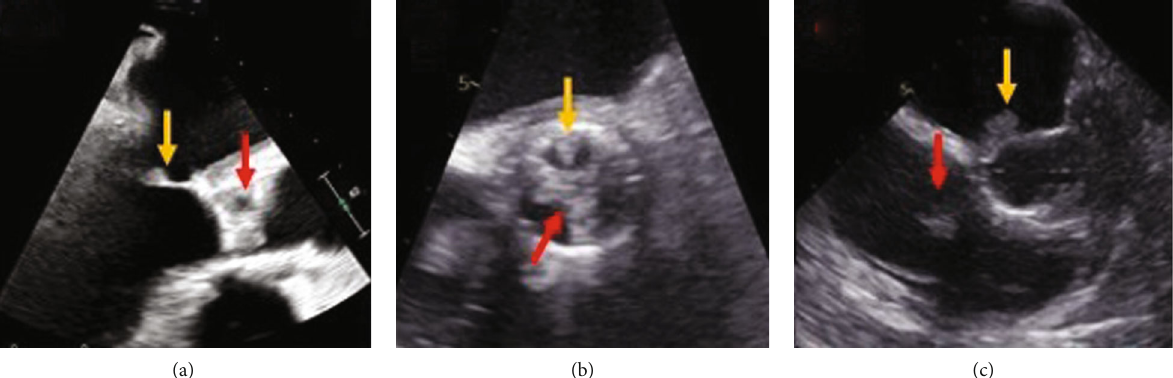
Figure 2: Transesophageal echocardiography of infected TAVR. (a) Thickened TAVR lea fl ets (red arrow) and vegetation of the mitral valve (yellow arrow). (b) Thickened TAVR lea fl ets (red arrow) and vegetation of the aortic cusp (yellow arrow). (c) Vegetations of the tricuspid valve (red arrow) and aortomitral continuity (yellow arrow).